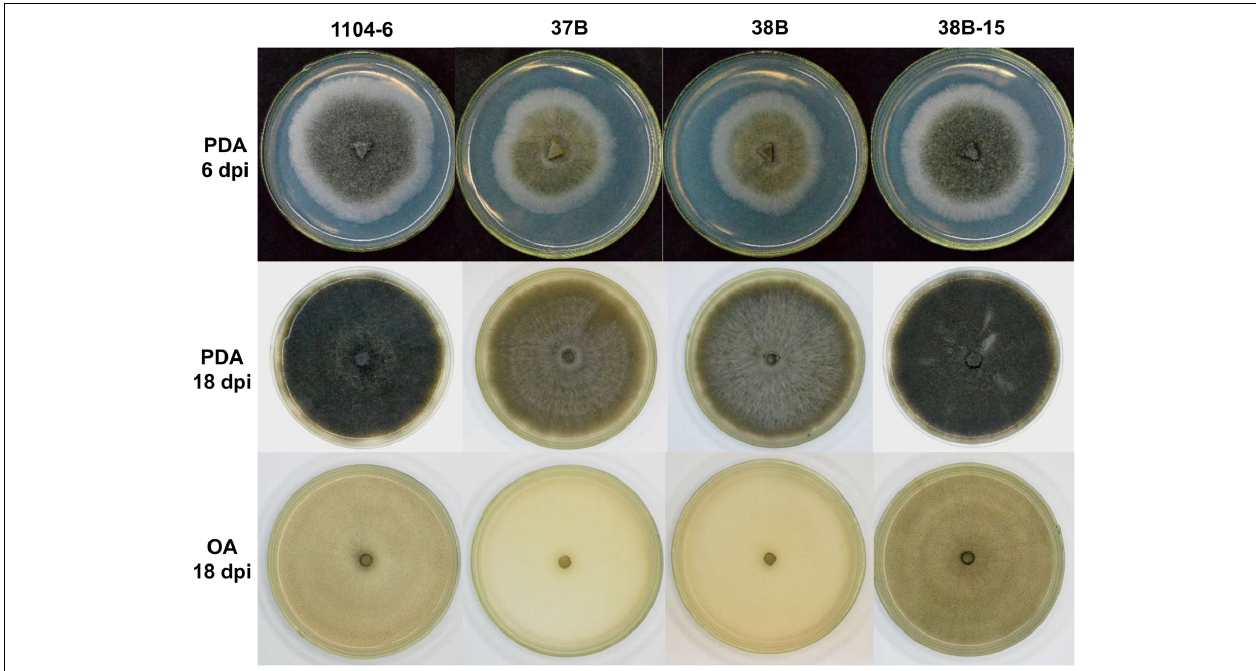
FIGURE 3 | Colony morphologies of wild type (WT, 1104-6), (cid:49) CfPMK1 mutants (37B, 38B), and complementation strain (38B-15) on potato dextrose agar (PDA) and oatmeal agar (OA) media.